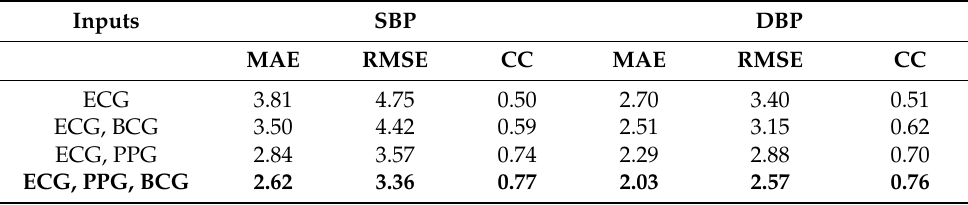
Table 3. Mean values of mean absolute error (MAE), root mean squared error (RMSE), and correlation coefficient (CC) for different inputs of personal-specific model.